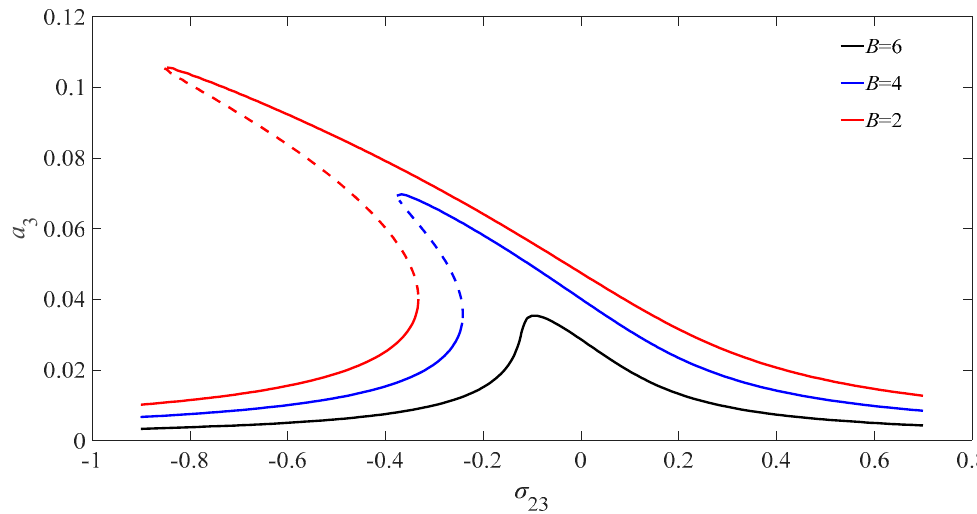
Figure 5. Diagram of internal resonant amplitude-frequency of nanobeam for different magnetic fields.